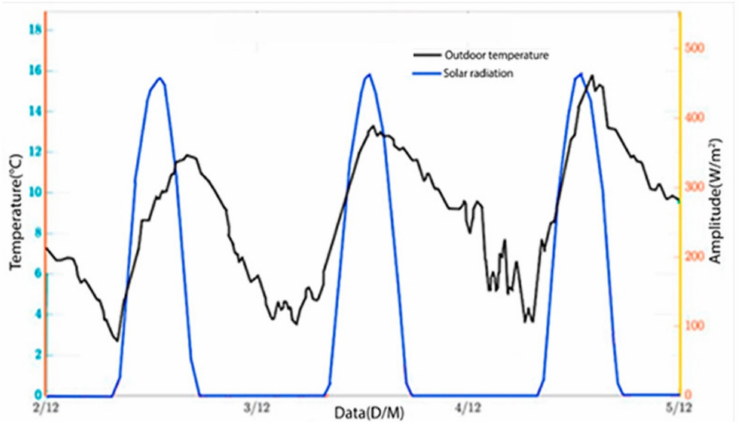
Figure 14. Environmental conditions during simulation.